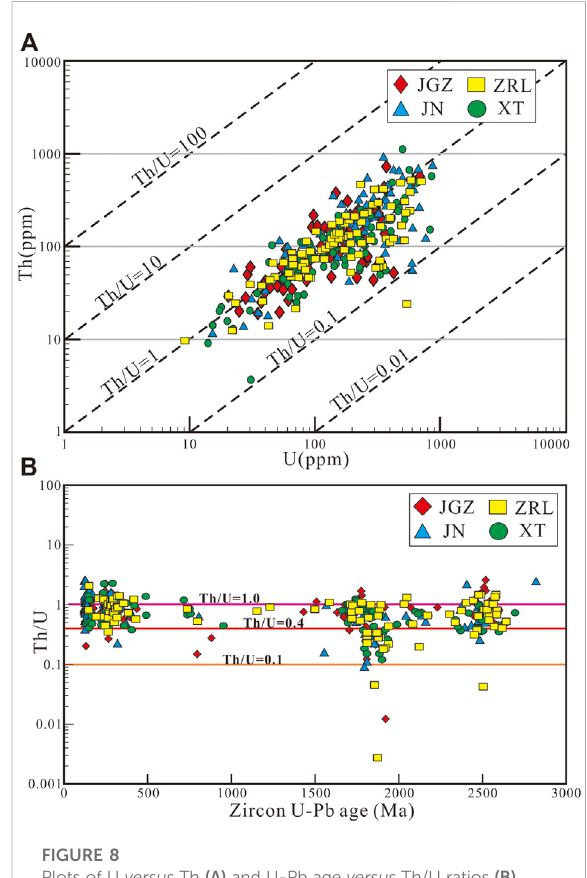
FIGURE 8 Plots of U versus Th (A) and U-Pb age versus Th/U ratios (B) for detrital zircon in this study.